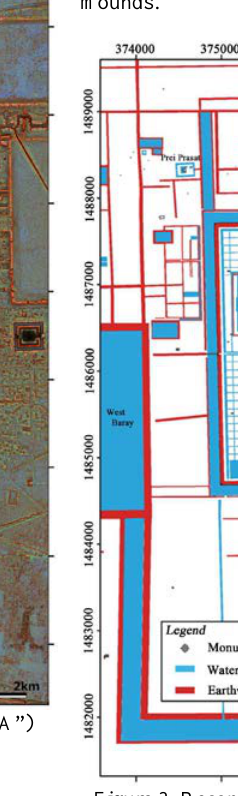
Figure 3. Reconstruction of water channels and earthworks in position of figure 4 shown in the black